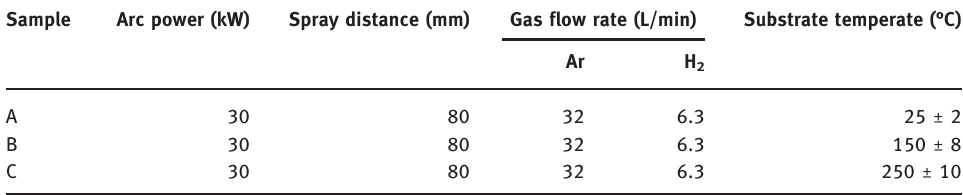
Table 1: Spray parameters for the deposition of cast iron splats on the aluminum surface.